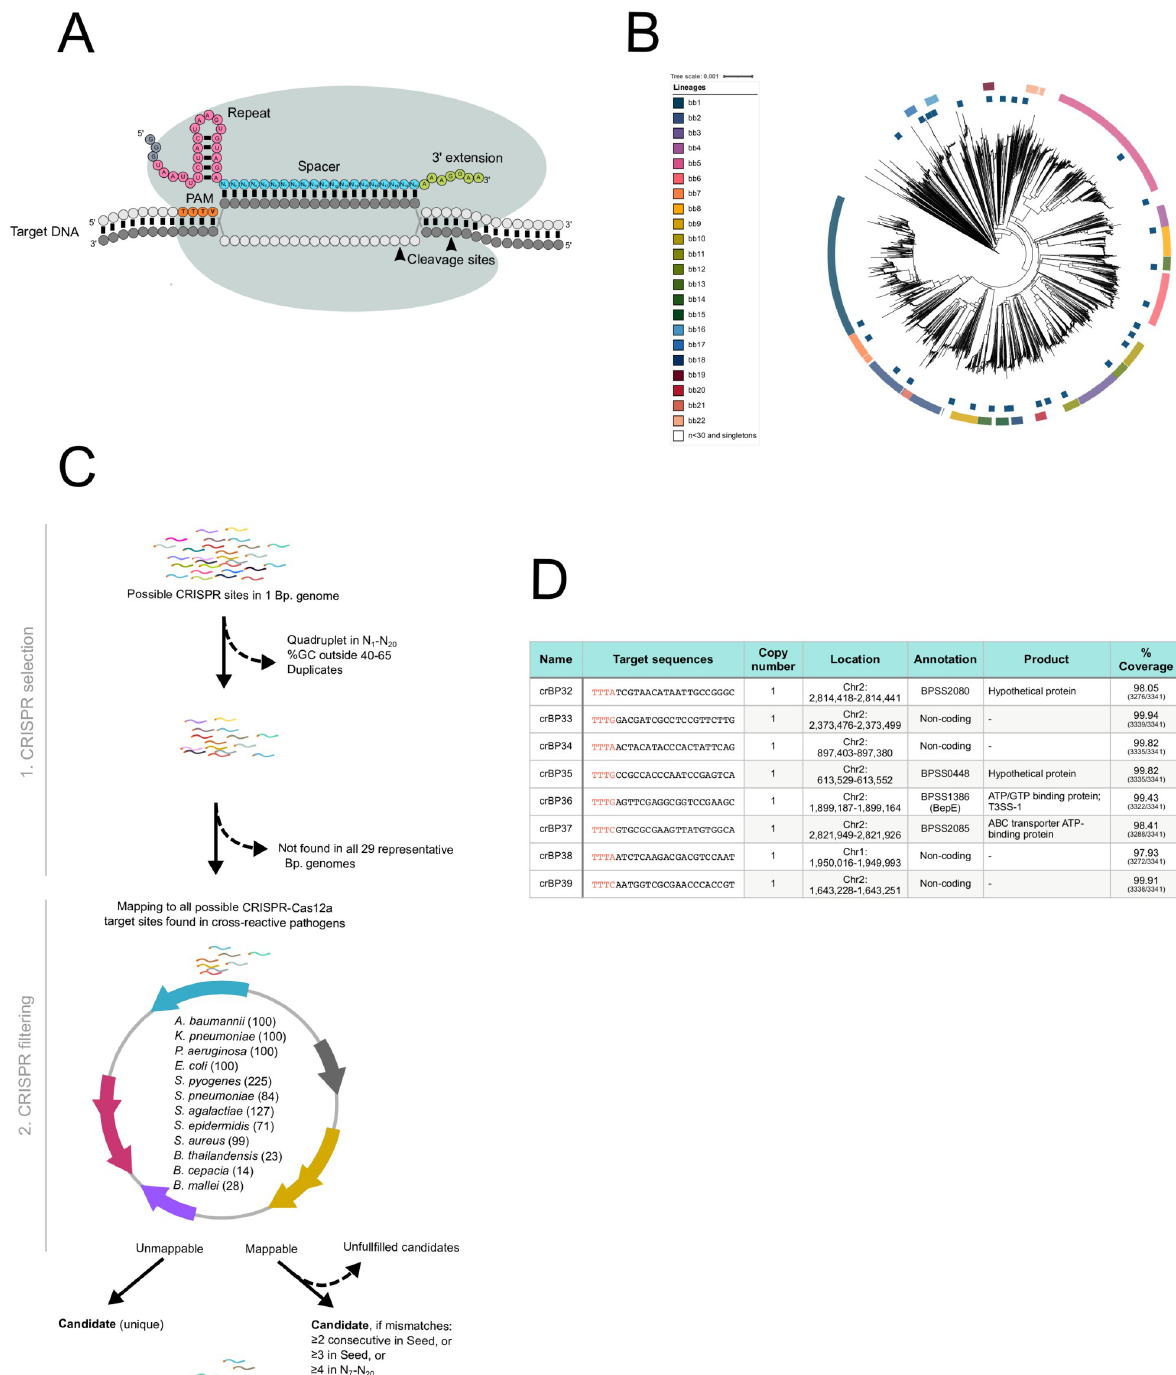
Fig 1. Designing B . pseudomallei -specific crRNA. (A) A schematic representation of CRISPR-Cas12a recognizing its target DNA. In forming a CRISPR-Cas12a RNP complex, Cas12a protein (grey lobes) needs to interact with crRNA. The crRNA consists of two essential elements—a repeat (pink dots) and a spacer (blue dots). The repeat is a structural scaffold of the crRNA, required for crRNA-Cas12a interaction, while the spacer is used for target recognition. An extra 3’ extension (green dots) of the RNA is added in this study (see main text). Recognition of CRISPR-Cas12a RNP complex to its target DNA is specified by base-pairing interaction between a 20-nt spacer of crRNA and a template strand of the target DNA (dark grey dots). PAM (TTTV; orange dots), however, is a prerequisite for this interaction. The target recognition leads to cleavage of the DNA at the PAM-distal sites (black arrow heads) and trans cleavage. (B) A phylogeny of global B . pseudomallei population (n = 3,341) collected between years of 1935 and 2018 (see Materials and Methods). The outer ring is colored coded by major lineages denoted as the Burkholderia Bayesian cluster